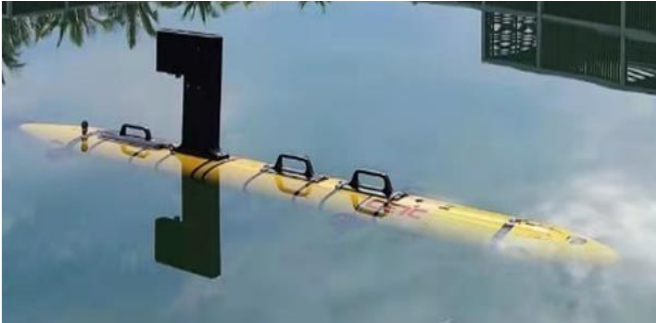
Figure 20. Self-made Autonomous Surface